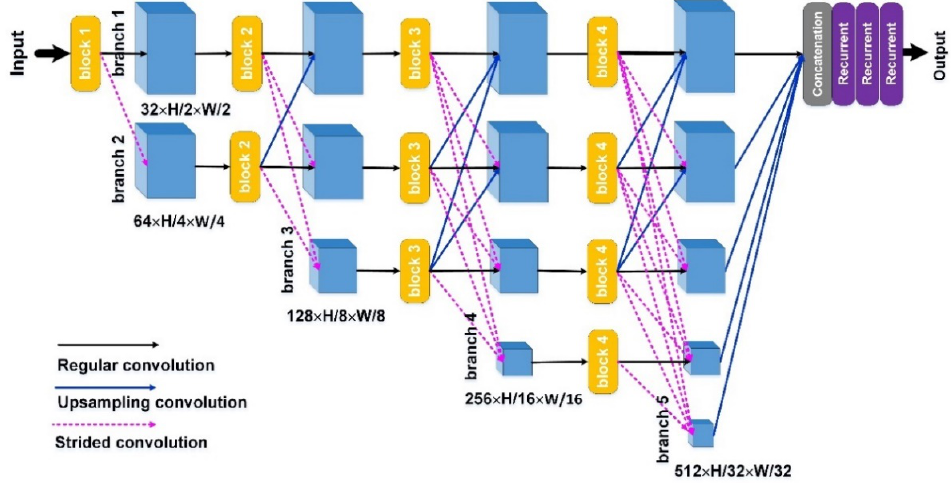
Figure 5. Architecture of mVHRNet, featuring a four-block structure and five branches.